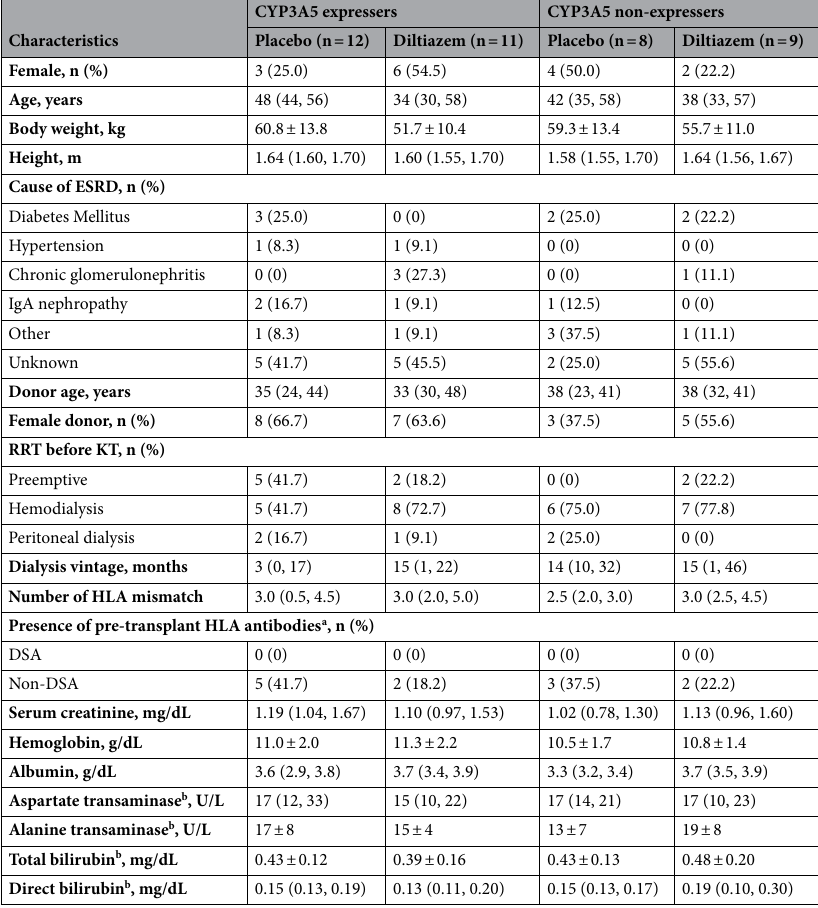
Table 1. Patient characteristics on day 7 after kidney transplantation. Values are expressed as count (%), mean ± SD, or median (interquartile range) for comparison reasons. ESRD end stage renal disease, DSA donor-specific antibody, HLA human leukocyte antigen, KT kidney transplantation, RRT renal replacement therapy. a Detection by single-antigen bead analysis, with mean fluorescence intensity of greater than or equal to 1500 (LABScreen Luminex kits, One Lambda, Canoga Park, CA, USA). b Data on day − 2 before kidney